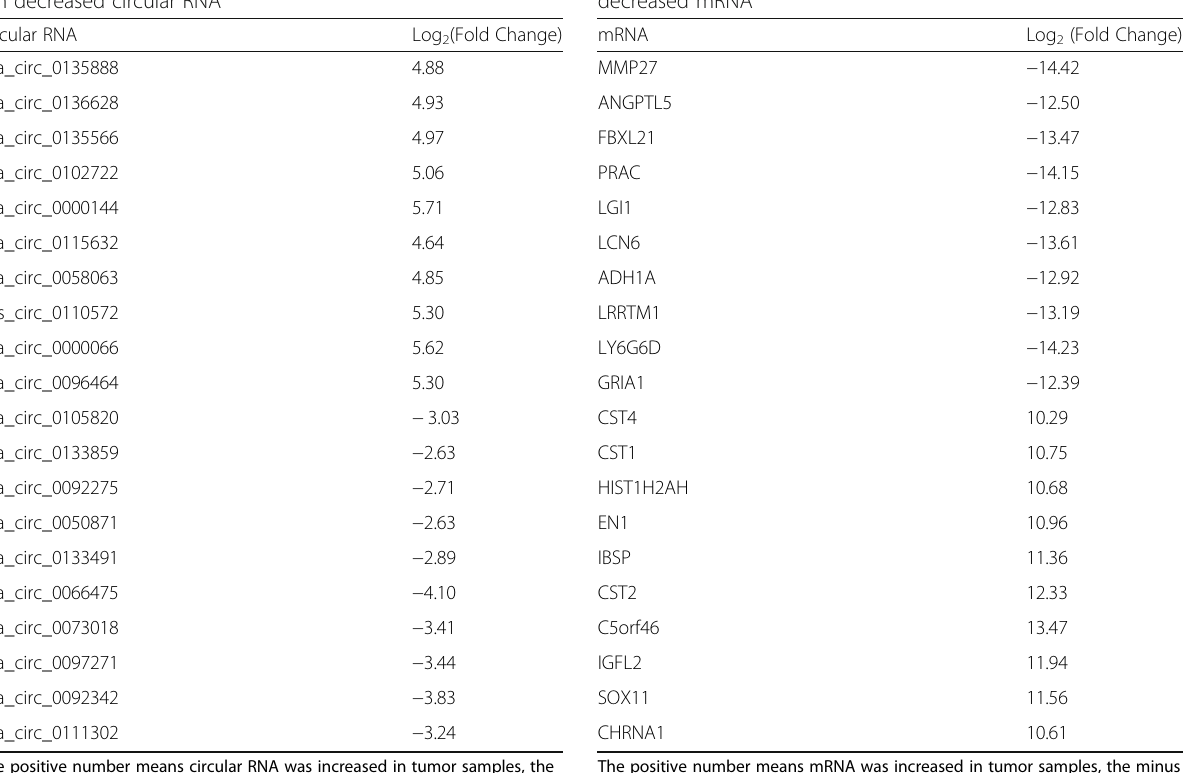
Table 4 Log 2 (Fold Change) of ten increased mRNA and